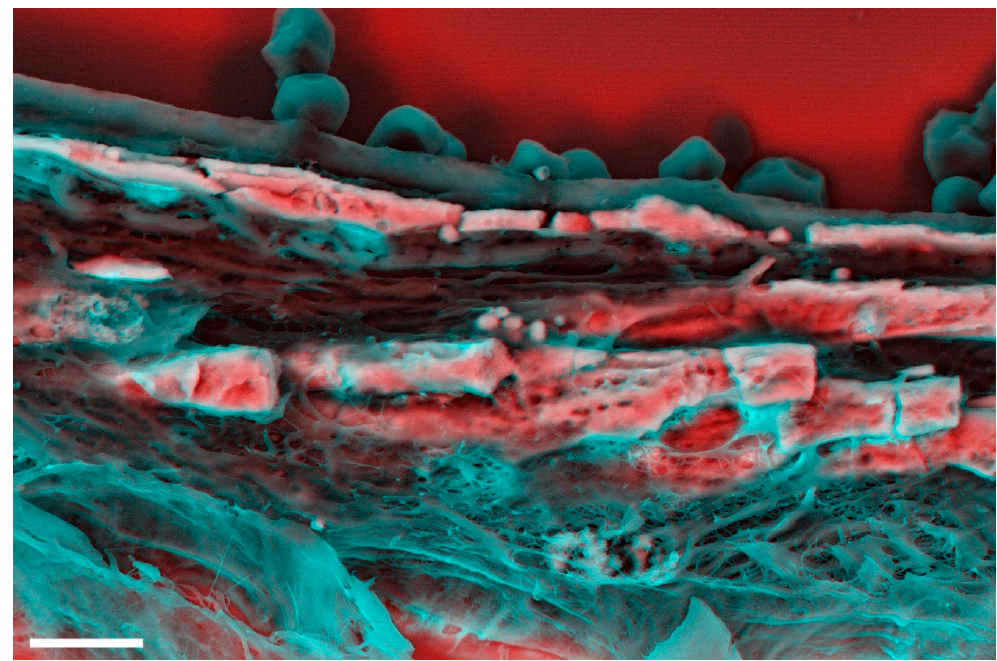
Figure 5. Density-dependent colour-scanning electron micrographs of intracranial vascular calcification. Red and pink indicate inorganic and turquoise (blue/green) indicates organic material. Scale bar = 4 µm.